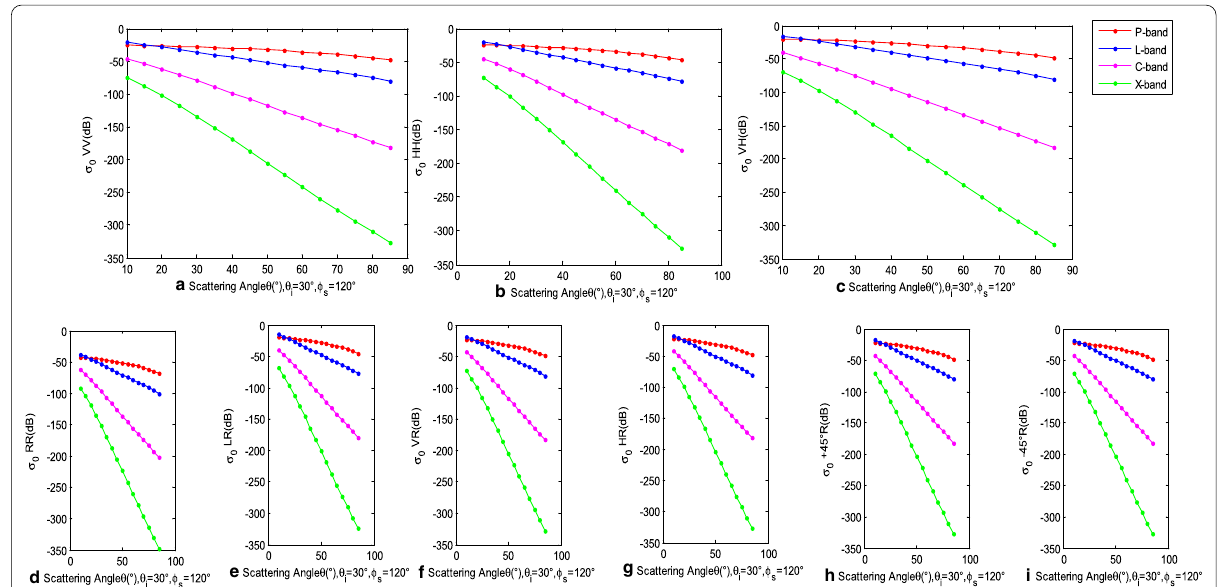
Fig. 6 Various polarizations random rough surface scattering cross section versus scattering angle for P-, L-, C- and X-band at θ i = 30 o , ϕ s = 120